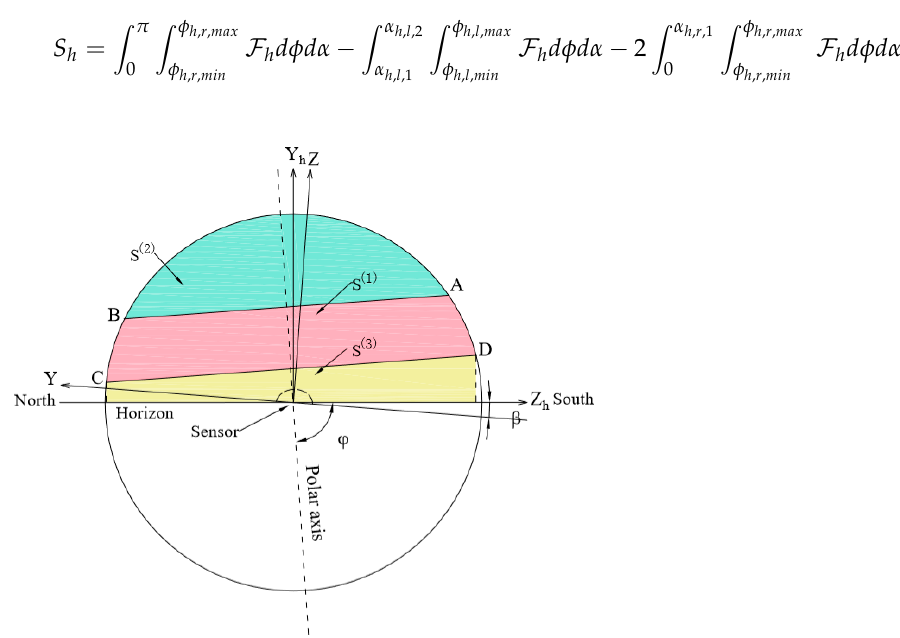
Figure 10. Schematic diagram for the calculation of S h while d r ≤ 0, y h , C > 0 and φ h , r , max < π − β .